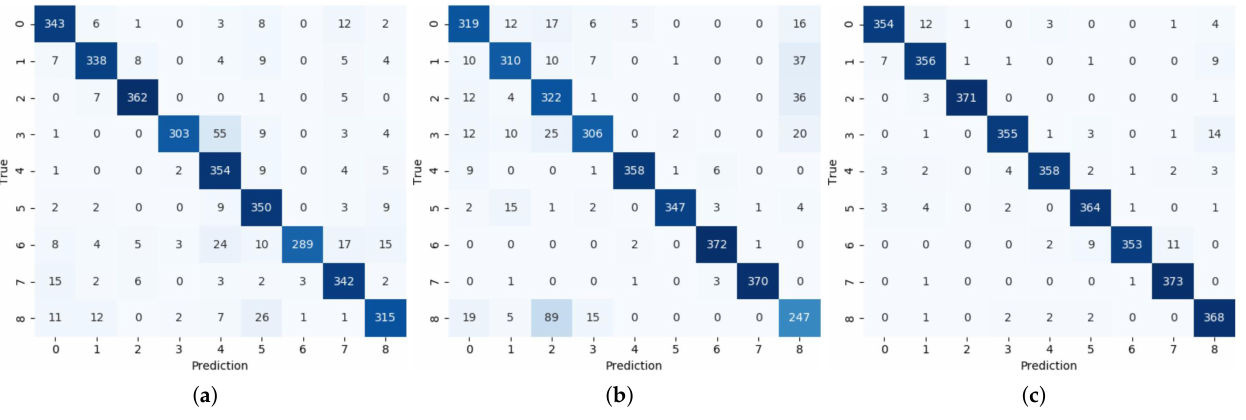
Figure 9. Confusion matrix of HVI system: ( a ) voice only; ( b ) radar only; ( c ) voice and radar